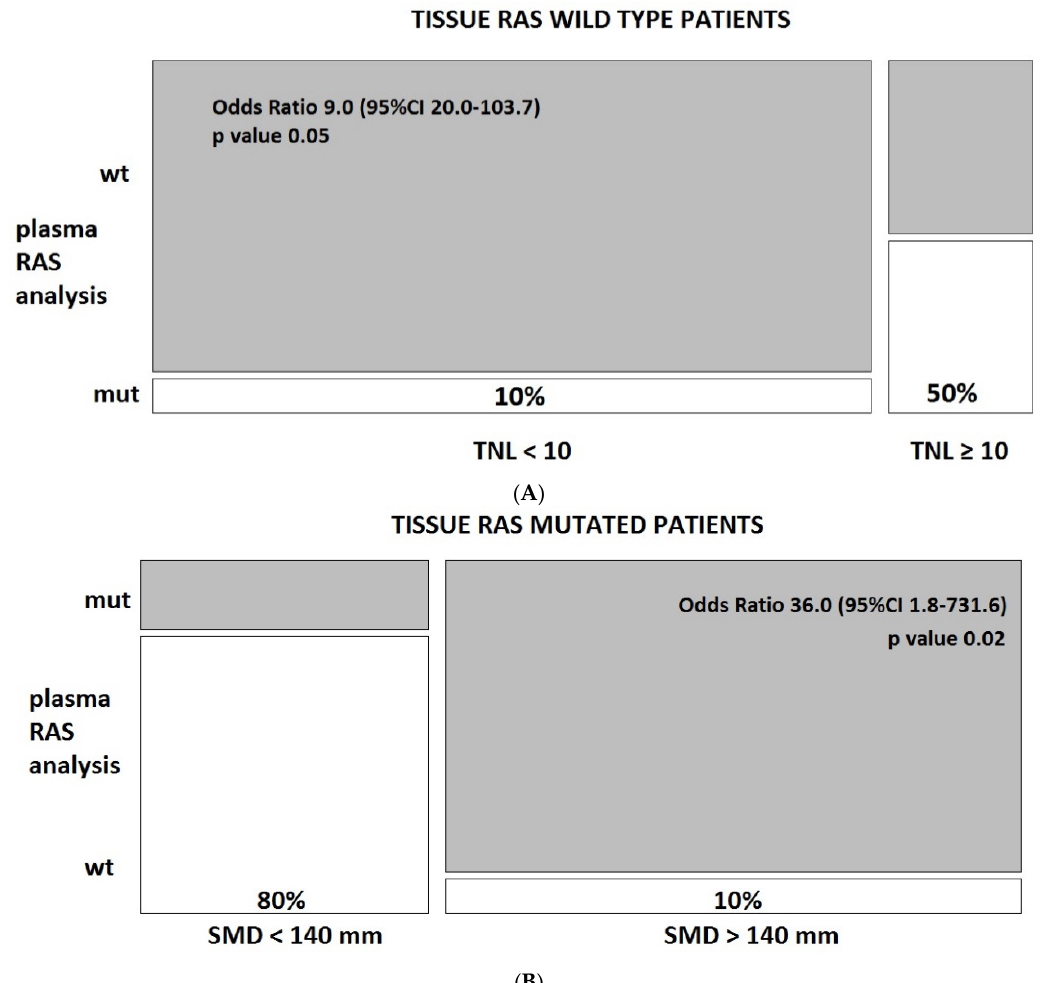
Figure 3. Mosaic plot of risk of discordance according to total number of tumor lesions (TNL) and sum of the maximum diameter (SMD) of all lesions in tissue RAS wild type ( A ) ( n = 24) and mutated patients( B ) ( n = 15).